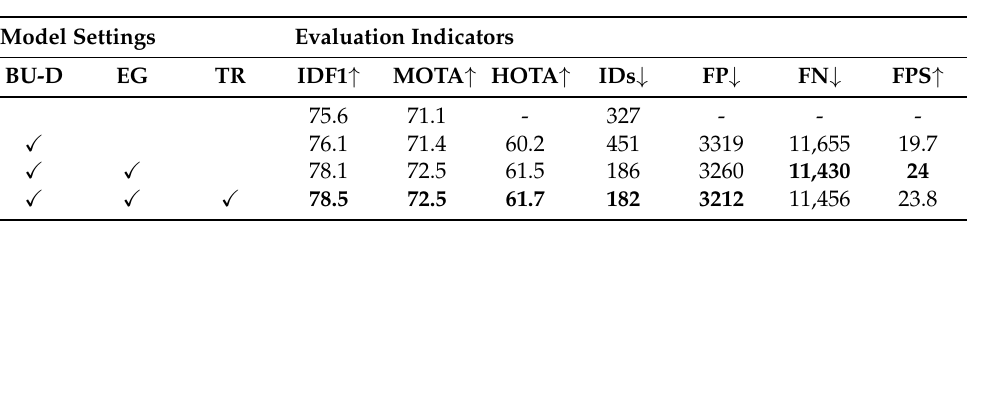
Table 1. Ablation experiment on SimpleTrack. (cid:88) denotes addition of this module to the baseline, which is FairMOT. BU-D, EG and TR stand for bottom-up decoupling, EG similarity matrix and tracking retrieval strategy, respectively. The best results are shown in bold